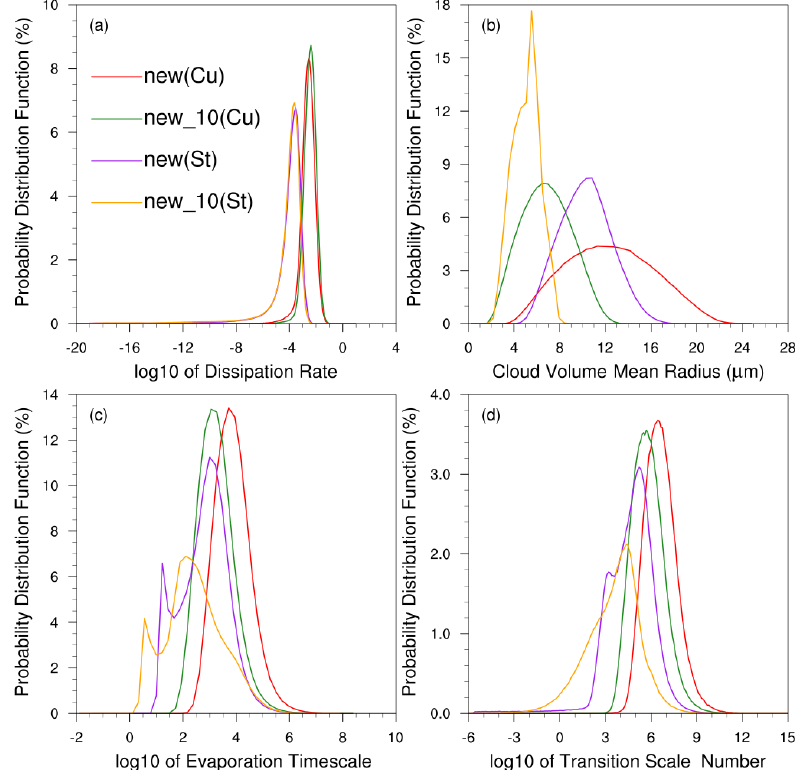
Figure 6. Probability distribution functions (PDFs) of (a) turbulence dissipation rate ( ε ), (b) cloud droplet volume mean radius ( r v ), (c) evap- oration timescale ( τ evap ), and (d) transition scale number ( N L ) of cloud grids experiencing the entrainment–mixing process in the simulations with the new entrainment–mixing parameterization for the cumulus case (Cu, the solid lines) and the stratocumulus case (St, the dashed lines), respectively. The experiments are detailed in Table